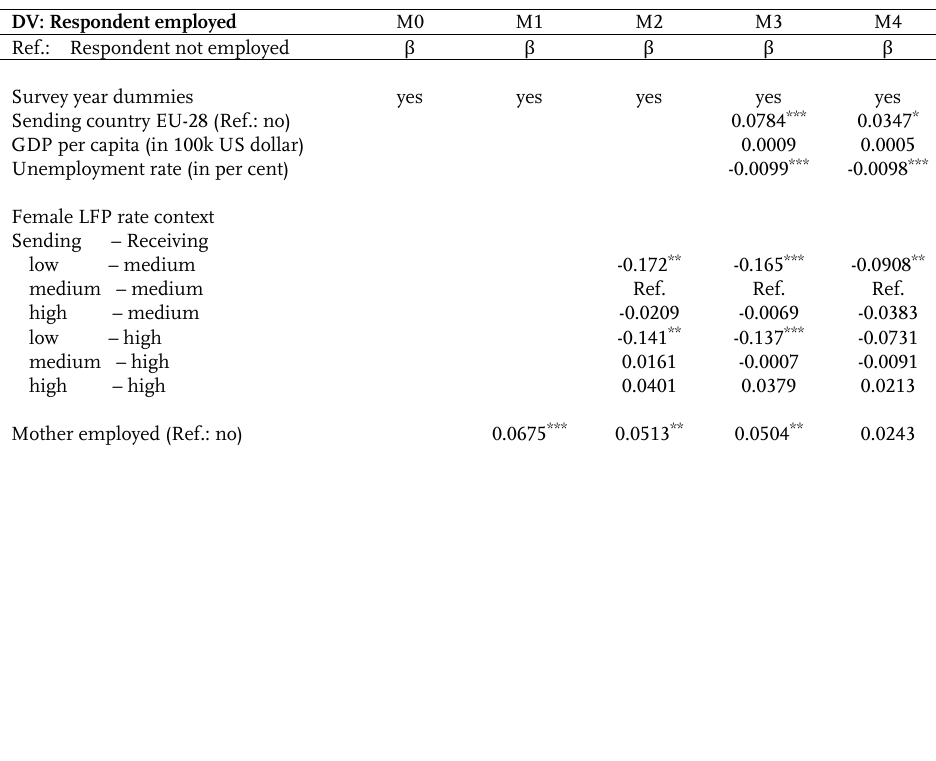
Table 2 : Linear multilevel probability models for female immigrants’ employment